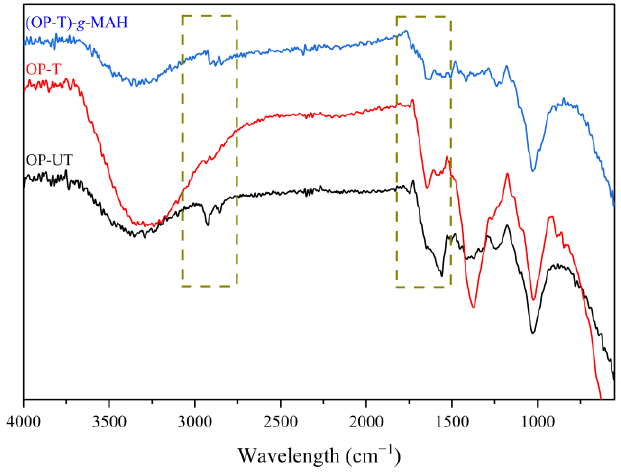
Figure 2. FTIR spectra of the untreated filler (OP-UT), treated filler (OP-T) and functionalised filler ((OP-T)- g -MAH).